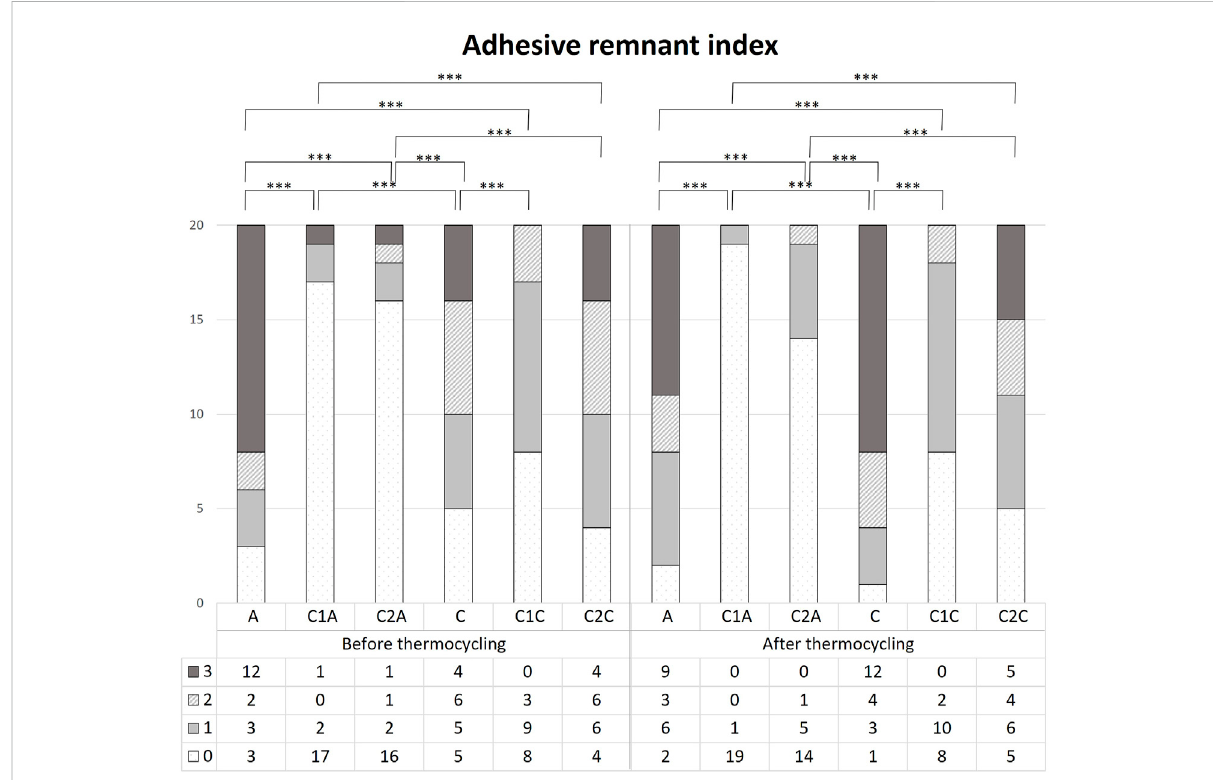
FIGURE 8 Comparison of the adhesive remnant index scores before and after 10,000 thermocycles. This fi gure presents the data in Table 3. *** indicates signi fi cance at p < 0.001.